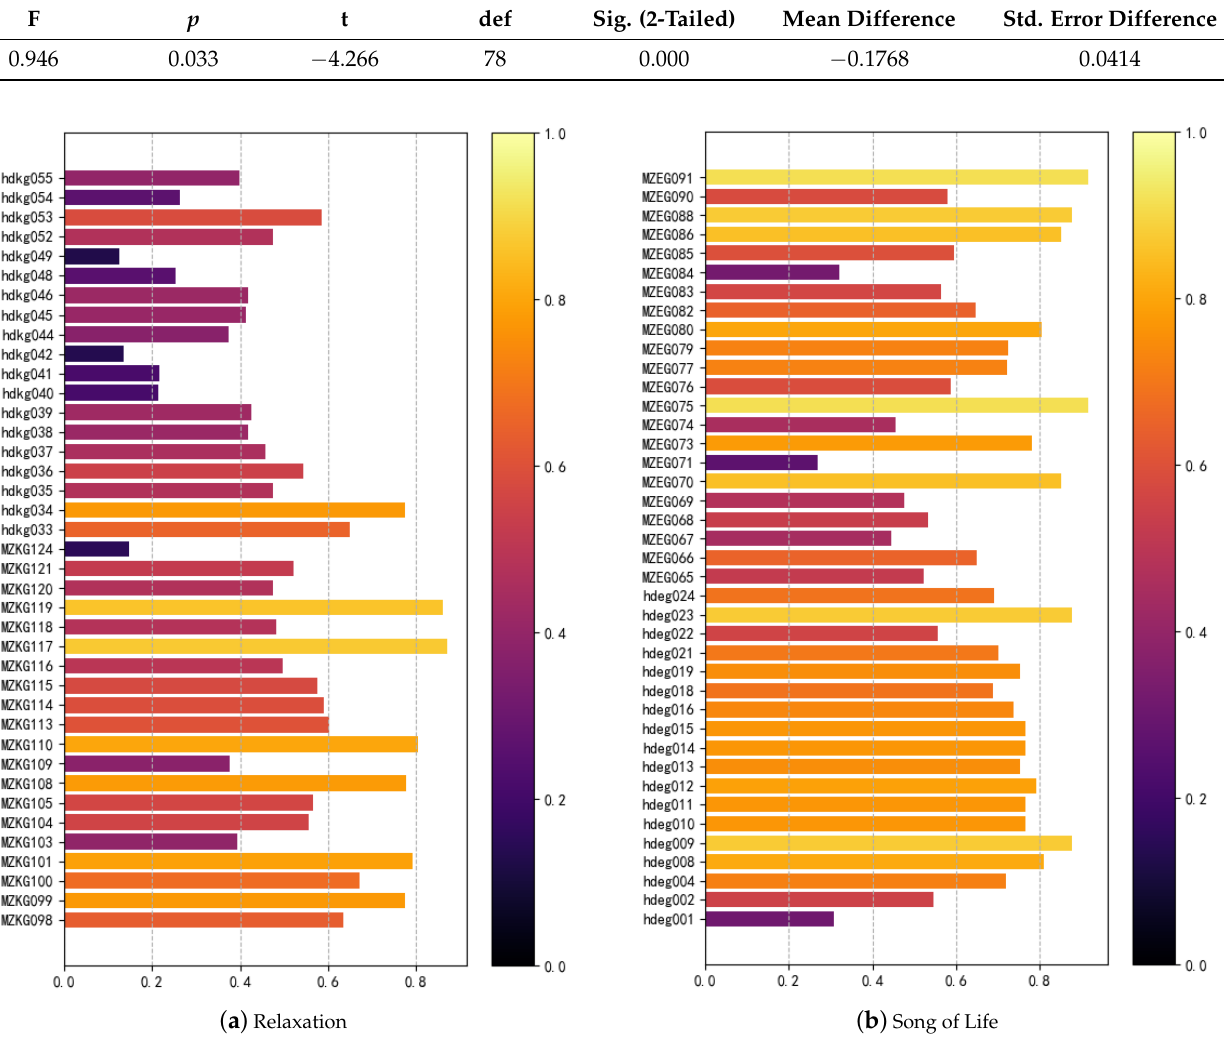
Table 9. Independent samples t -test result of satisfaction for both groups.